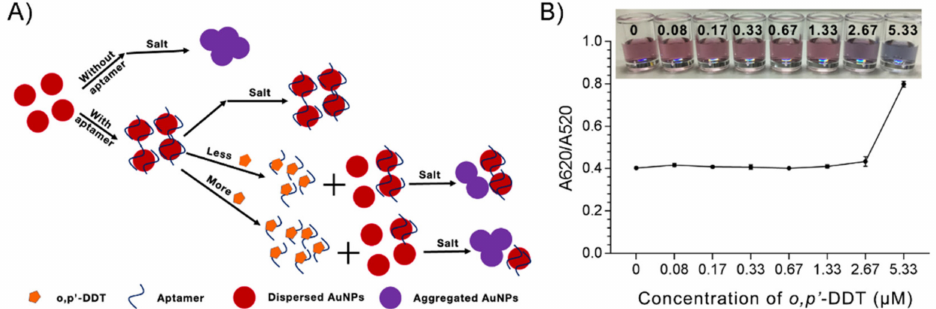
Figure 5. Gold Nanoparticles (AuNPs) colorimetric assay. ( A ) Schematic principle of the assay. ( B ) Aggregation response to o,p’ -DDT addition quantified by absorbance ratio. Insert image: Digital image of the samples represented in ( B